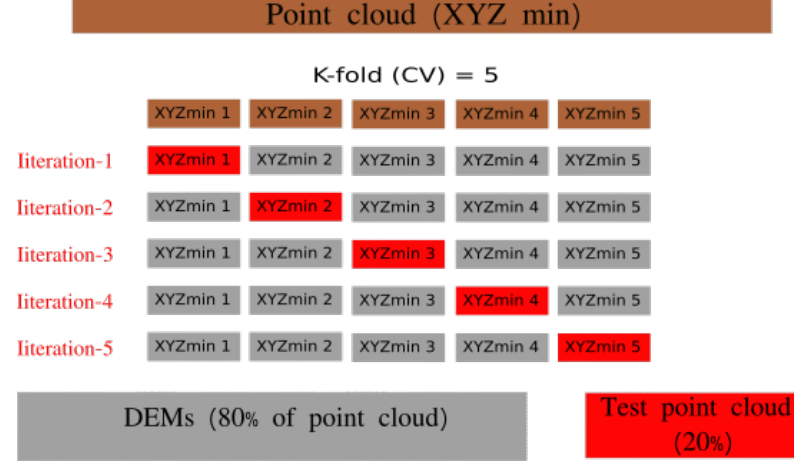
Figure 8. K-fold cross-validation